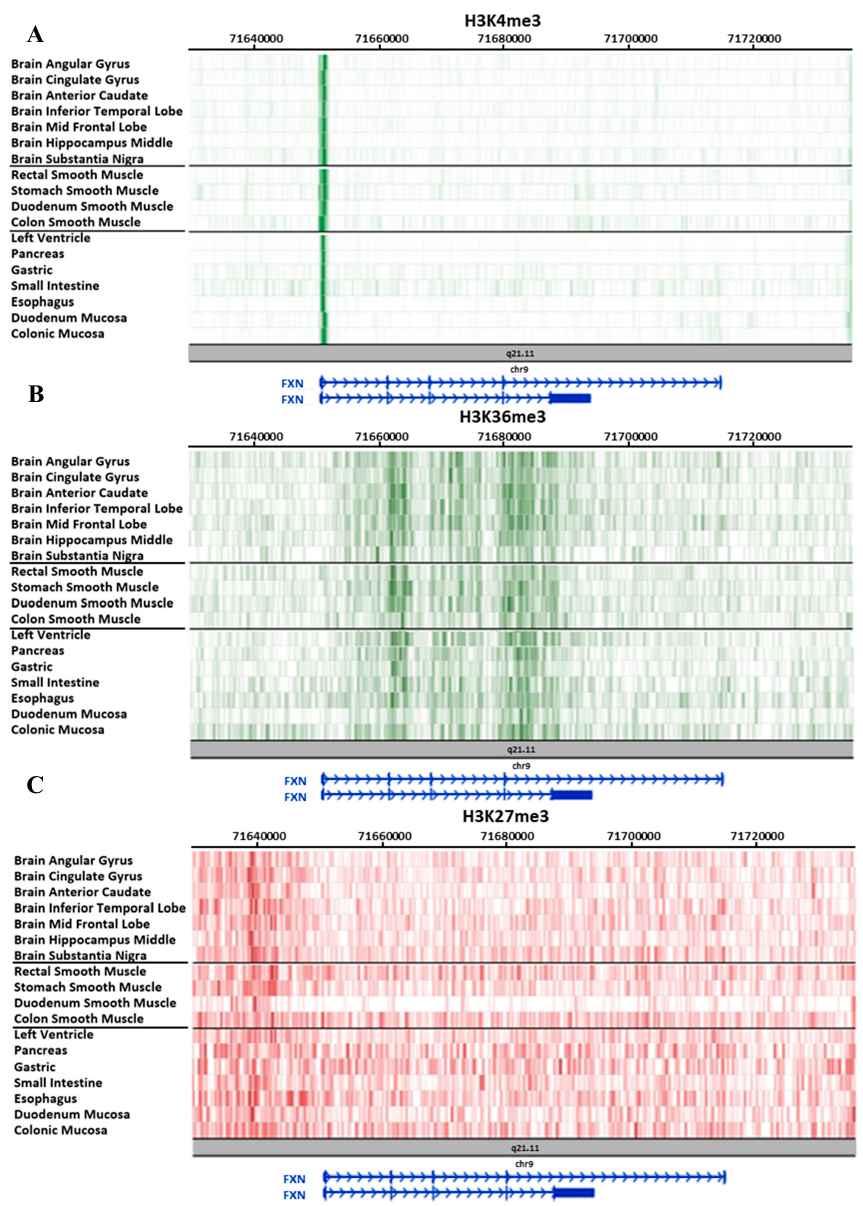
Figure 3. Epigenetic marks with a common pattern across the different tissues provided by Roadmap. All data were collected from the Roadmap database [47] and visualized in its own browser (https://epigenomegateway.wustl.edu/browser/roadmap). ( A ) H3K4me3 mark is related to promoter regions; ( B ) H3K36me3 mark is associated with active transcription; ( C ) H3K27me3 mark is related to heterochromatin. Tissues are organized in three groups: brain, muscle, and other tissues.